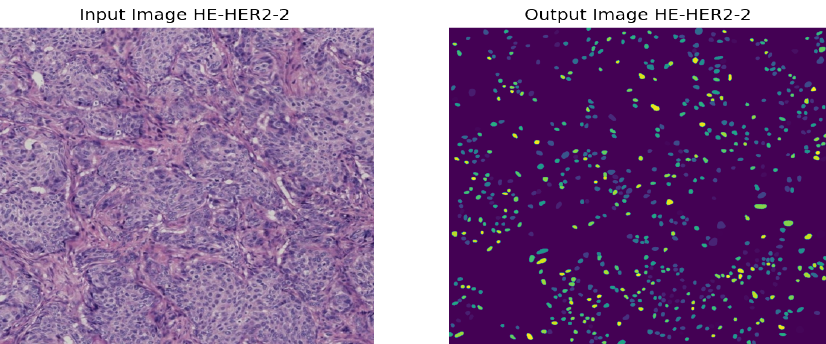
Figure 13. Nuclei segmentation of HER2-2+ Breast Cancer.